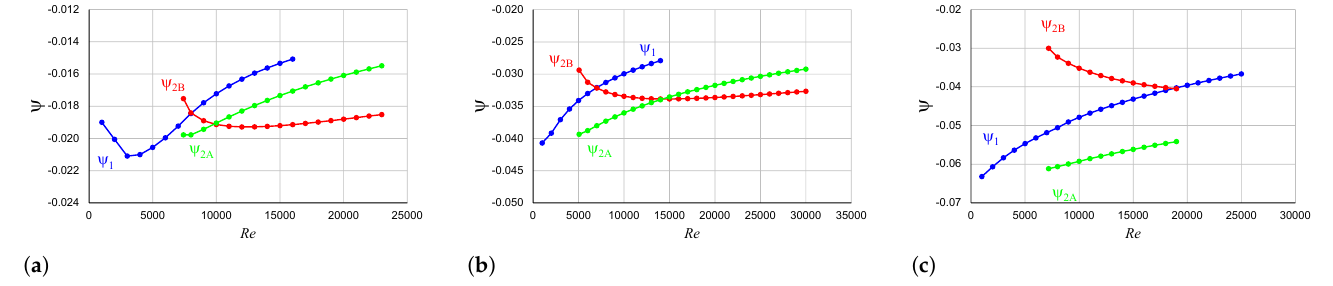
Figure 17. The schematic view of the vortices and local vortex centers with blue, red and green color codes in the 1st and 2nd solutions for the considered aspect ratio semi-ellipses. ( a ) 1st solution, D = 0.26. ( b ) 1st solution, D = 0.5. ( c ) 1st solution, D = 0.8. ( d ) 2nd solution, D = 0.26. ( e ) 2nd solution, D = 0.5. ( f ) 2nd solution, D = 0.8.